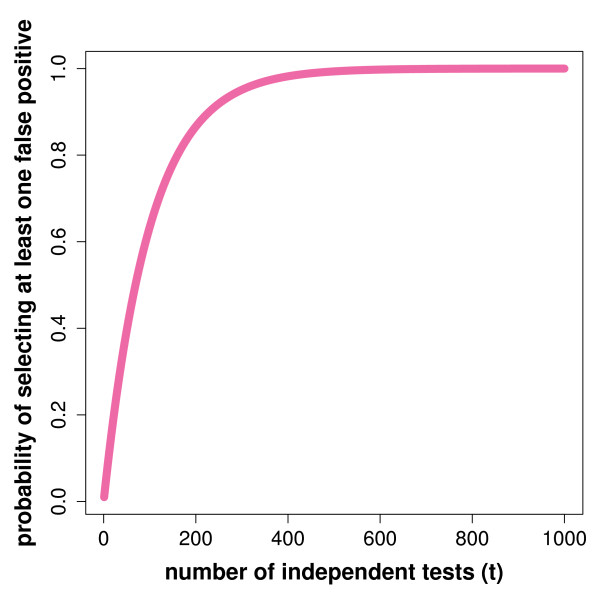
Dependence of
Pr
(
V
 ≥ 1|
α
  =  0.01,
t
) on the number
t
of tested hypotheses.